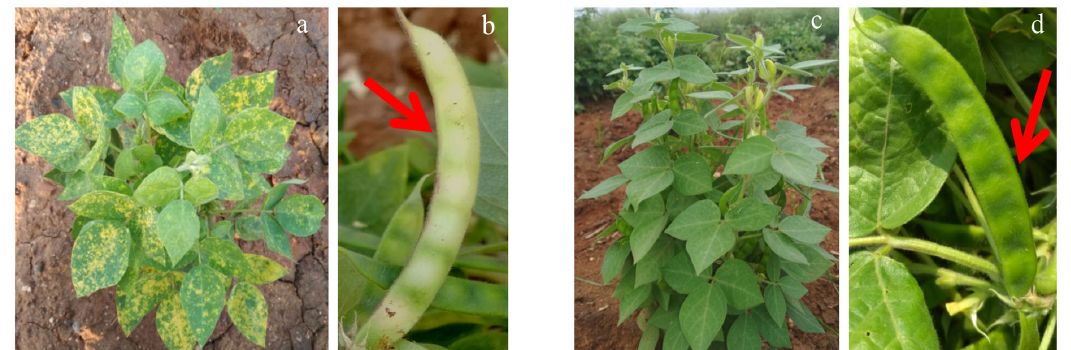
Figure 1. ( a ) A HgYMV infected plant of highly susceptible horse gram genotype PLS 6194. ( b ) A HgYMV infected yellow and ill ‐ filled pod (indicated by red arrow) of the highly susceptible horse gram genotype PLS 6194. ( c ) A plant of highly resistant horse gram genotype PLS 6002 ( d ) A green and normal pod (indicated by red arrow) of the highly resistant horse gram genotype PLS